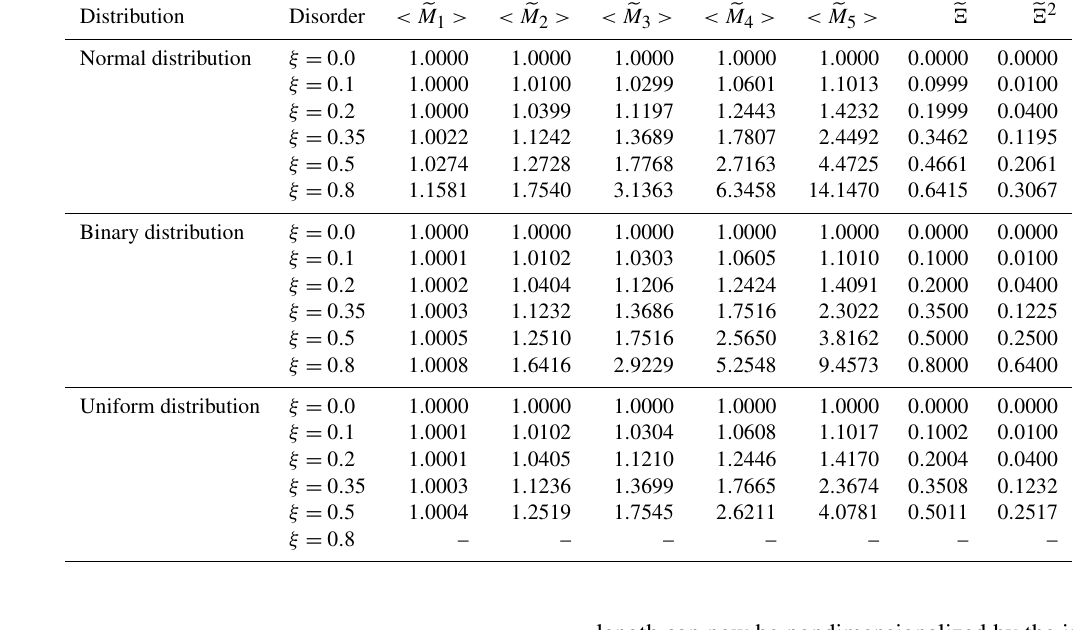
Table 2. Unscaled moments of ensemble-averaged distributions (500 ensembles) used for the one-dimensional chain (256 elements